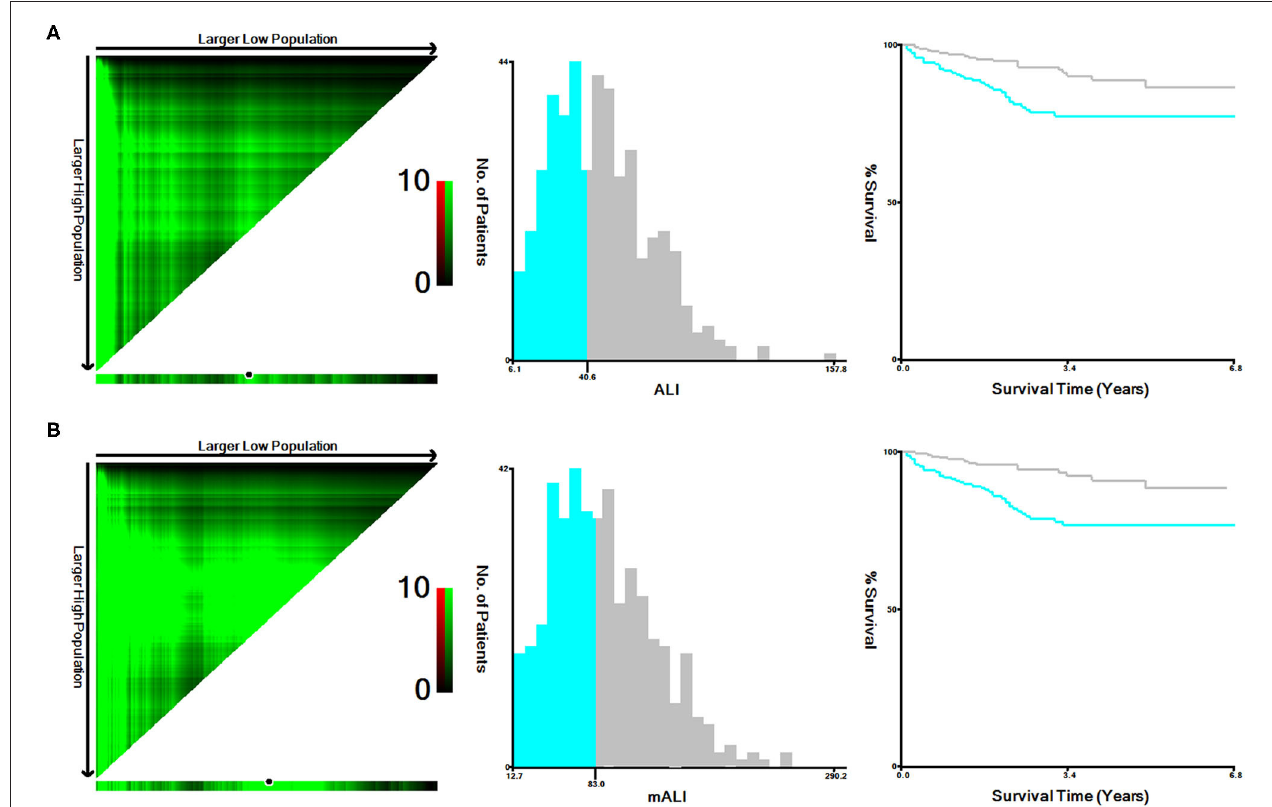
FIGURE 1 | X-tile stratified analysis of ALI and mALI. (A) ALI; (B) mALI. ALI, advanced lung cancer inflammation index; mALI, modified advanced lung cancer inflammation index.